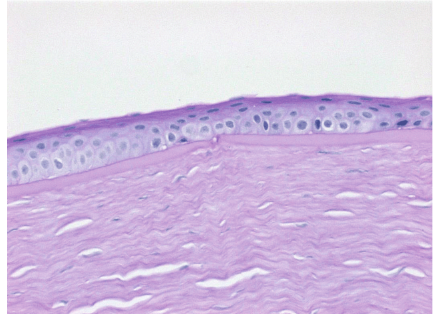
Figure 3: Histopathological section of corneal button illustrating dehiscence in Bowman’s membrane (periodic acid Schi ff stain, ×